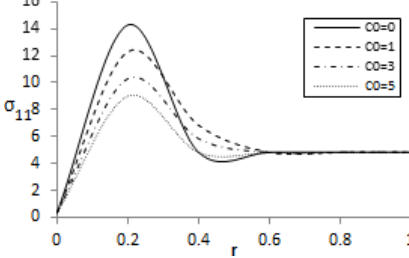
Figure 2: Distribution of radial stress with the